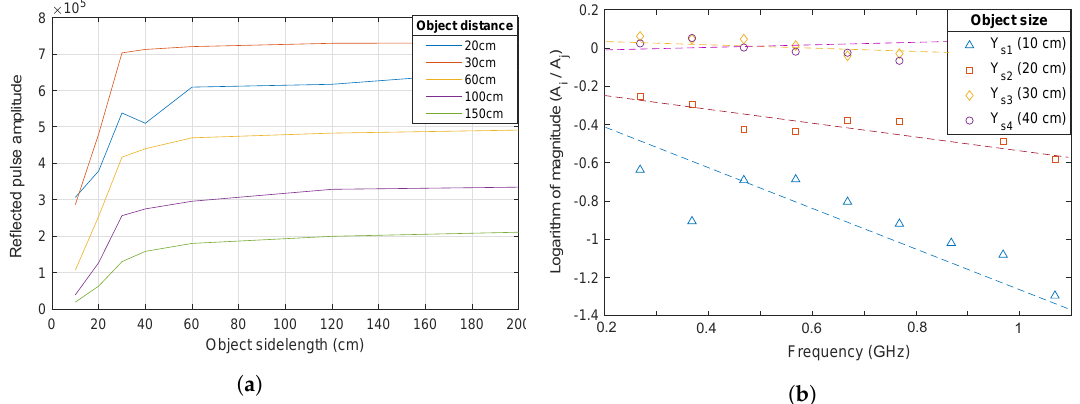
Figure 5. Experimental values of ( a ) amplitude vs. object side length for different object distance, = ln ( | A 20 = ln ( | A 30 = ln ( | A 40 | ) , Y | ) , Y | ) , and Y | ) vs. frequency, and ( b ) Y s 1 = ln ( | A 10 s 2 s 3 s 4 A r A r A r A r where A 10 , A 20 , A 30 , and A 40 represent pulses from objects with 10 cm, 20 cm, 30 cm, and 40 cm side lengths respectively, and A r is the reference pulse (dashed lines represent least square